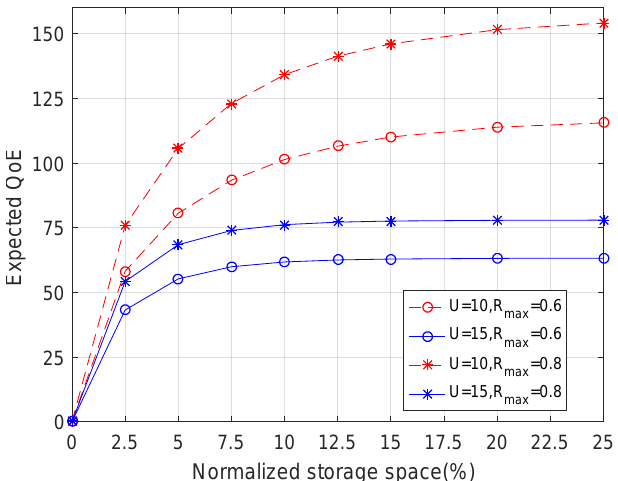
Figure 7. The expected QoE as a function of the normalized storage space, with varying values of the average number of users per BS and different distributions of the file